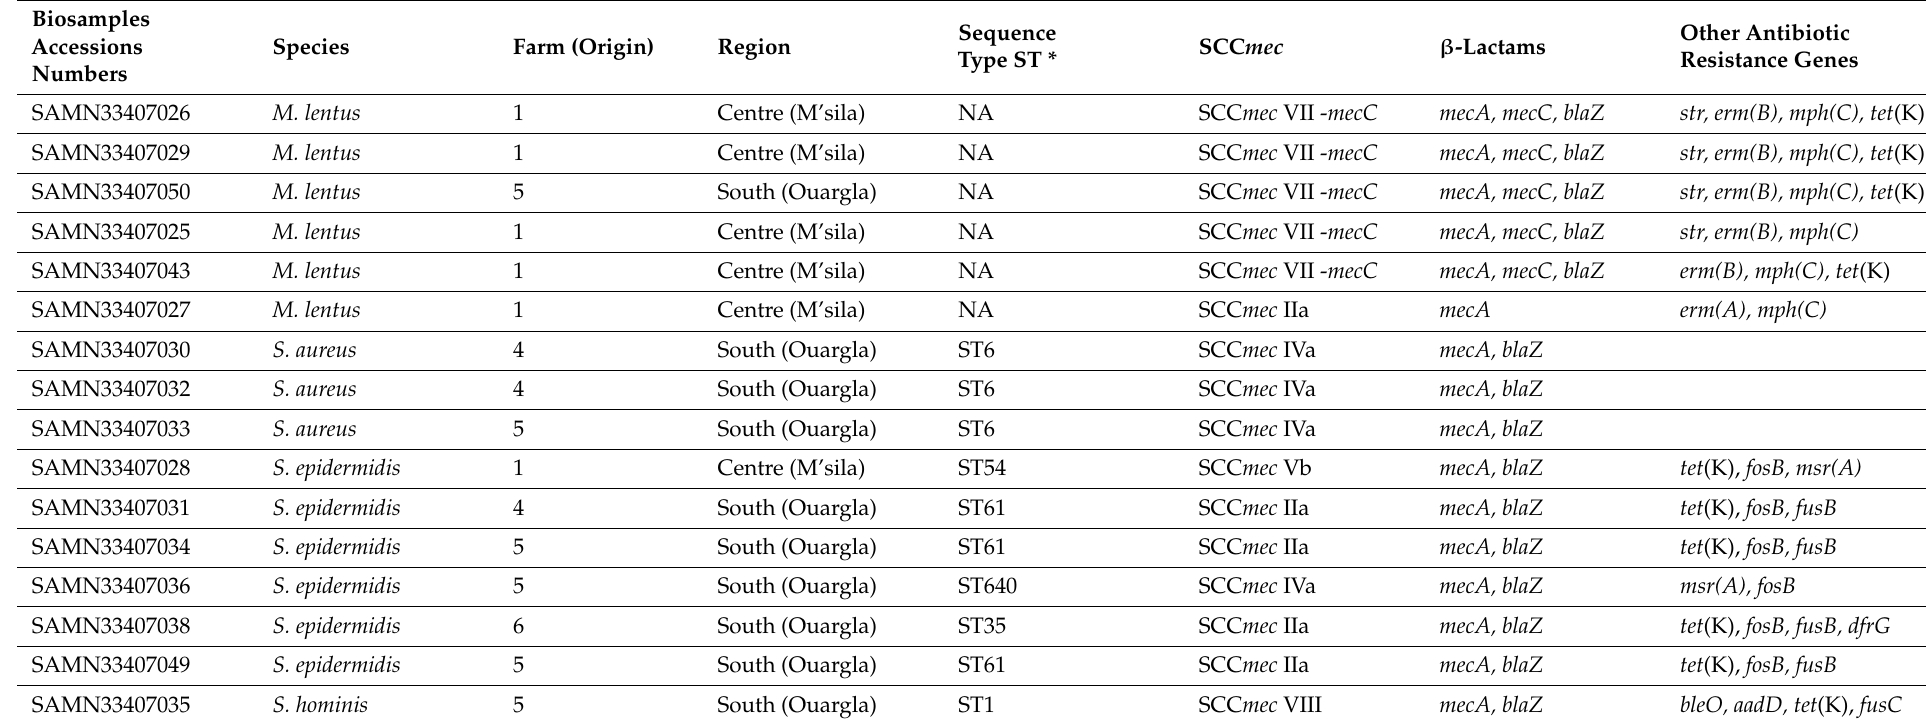
Table 2. Distribution of detected antimicrobial resistance genes in methicillin-resistant Staphylococcus and Mammaliicoccus